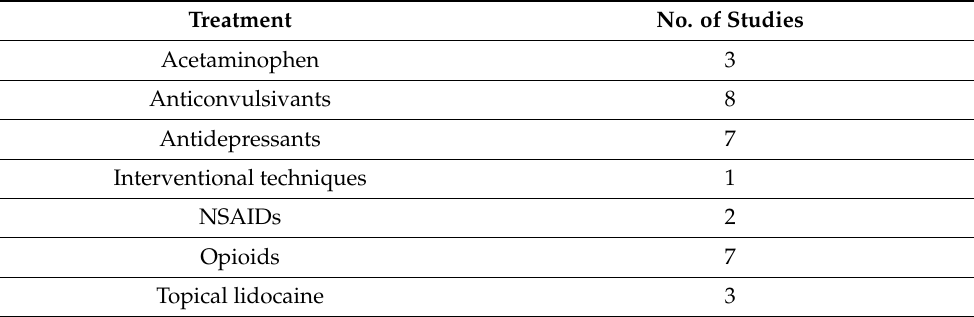
Table 4. Previous